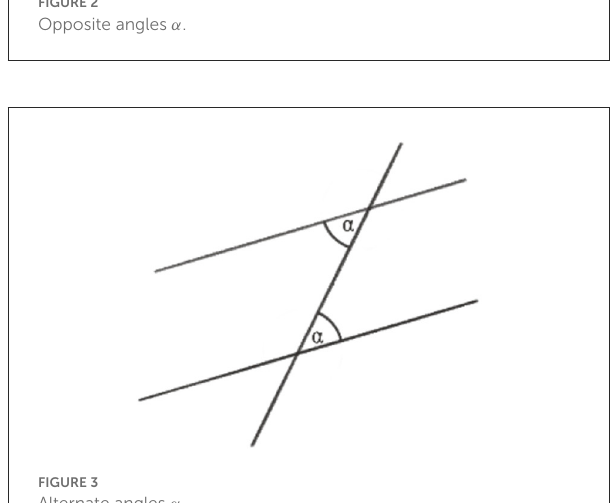
FIGURE3 Alternate angles α